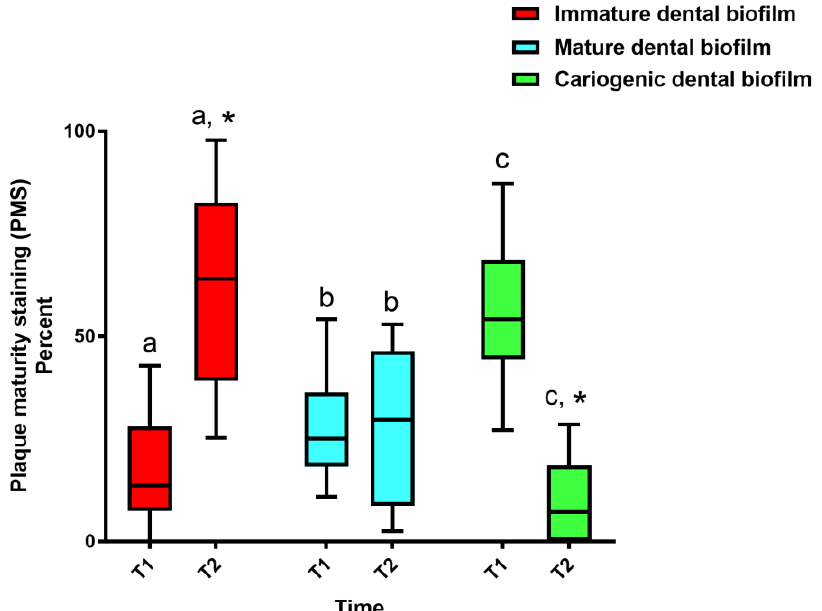
Figure 4. Frequency distribution of plaque maturity staining (PMS) in the EL group. Dental biofilm staining was performed before EL tying (T1) and at the 4-week follow-up (T2). The intervention was the combined horizontal–Charters–modified Bass tooth brushing technique. The boxes represent the interquartile range, and the horizontal bars within the boxes represent the median. The lower and upper ends of the vertical lines represent the 10th and 90th percentiles, respectively. The asterisks denote a significant difference in % PMS between T1 and T2 (Wilcoxon signed-rank test, p < 0.05). Different superscript letters indicate significant differences between the PMS at each time point (Kruskal – Wallis with Dunn – Bonferroni post hoc test, p < 0.05).